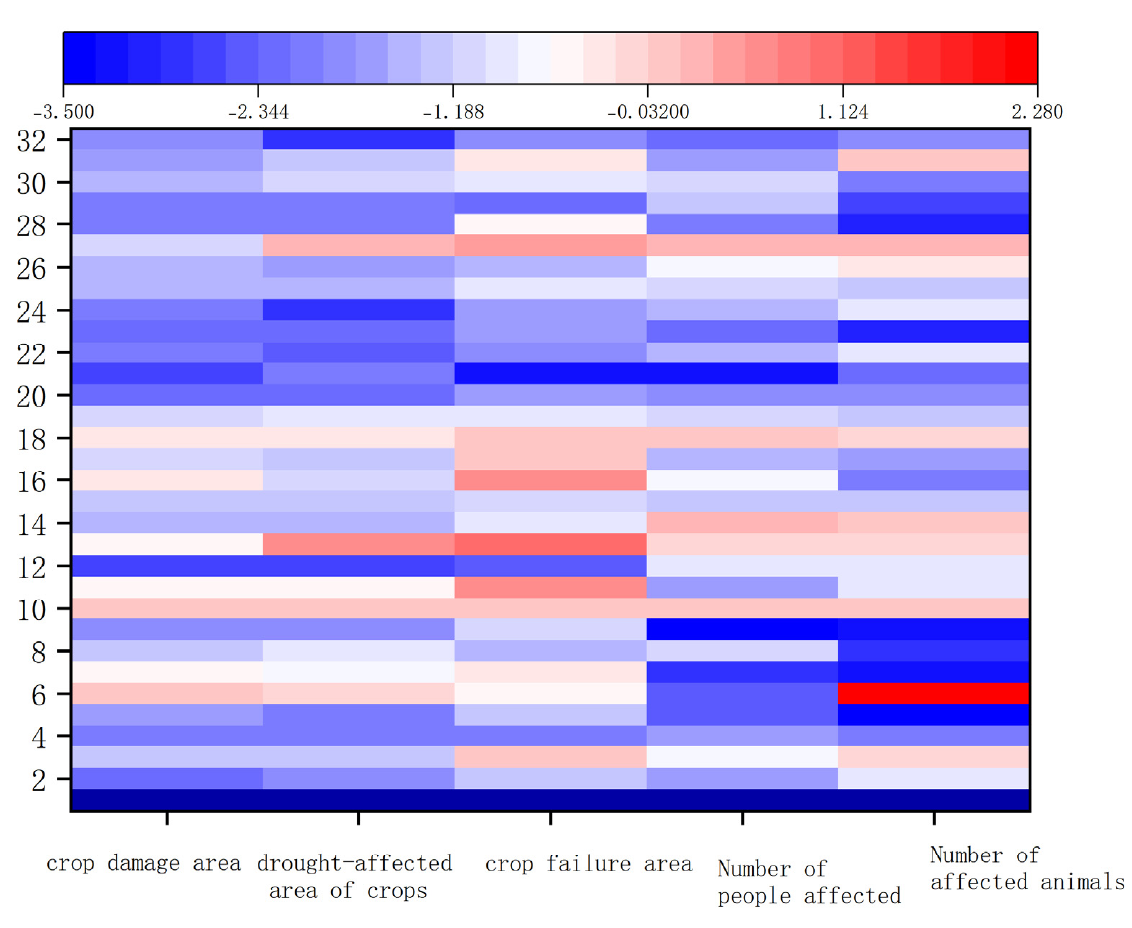
Figure 5. Heat map of the variation of drought indicators (1—blank control; 2—Beijing; 3—Tianjin;